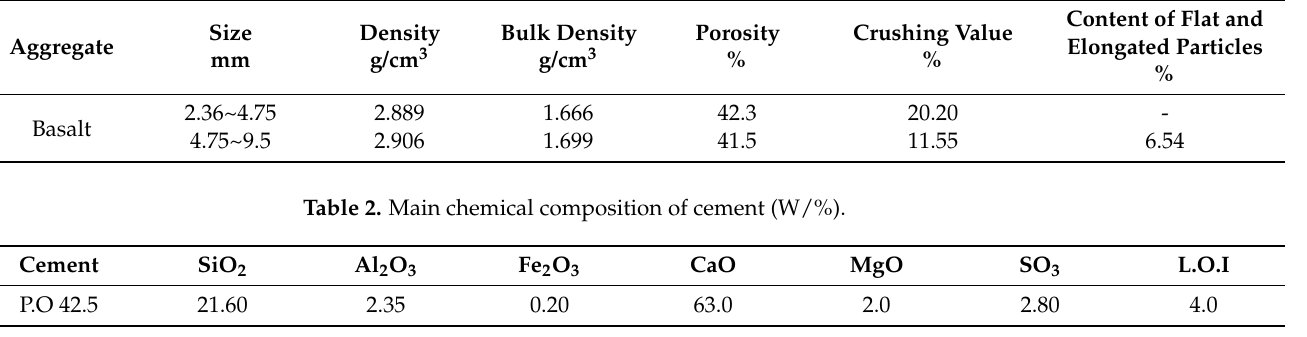
Table 1. Partial physical properties of the basalt.